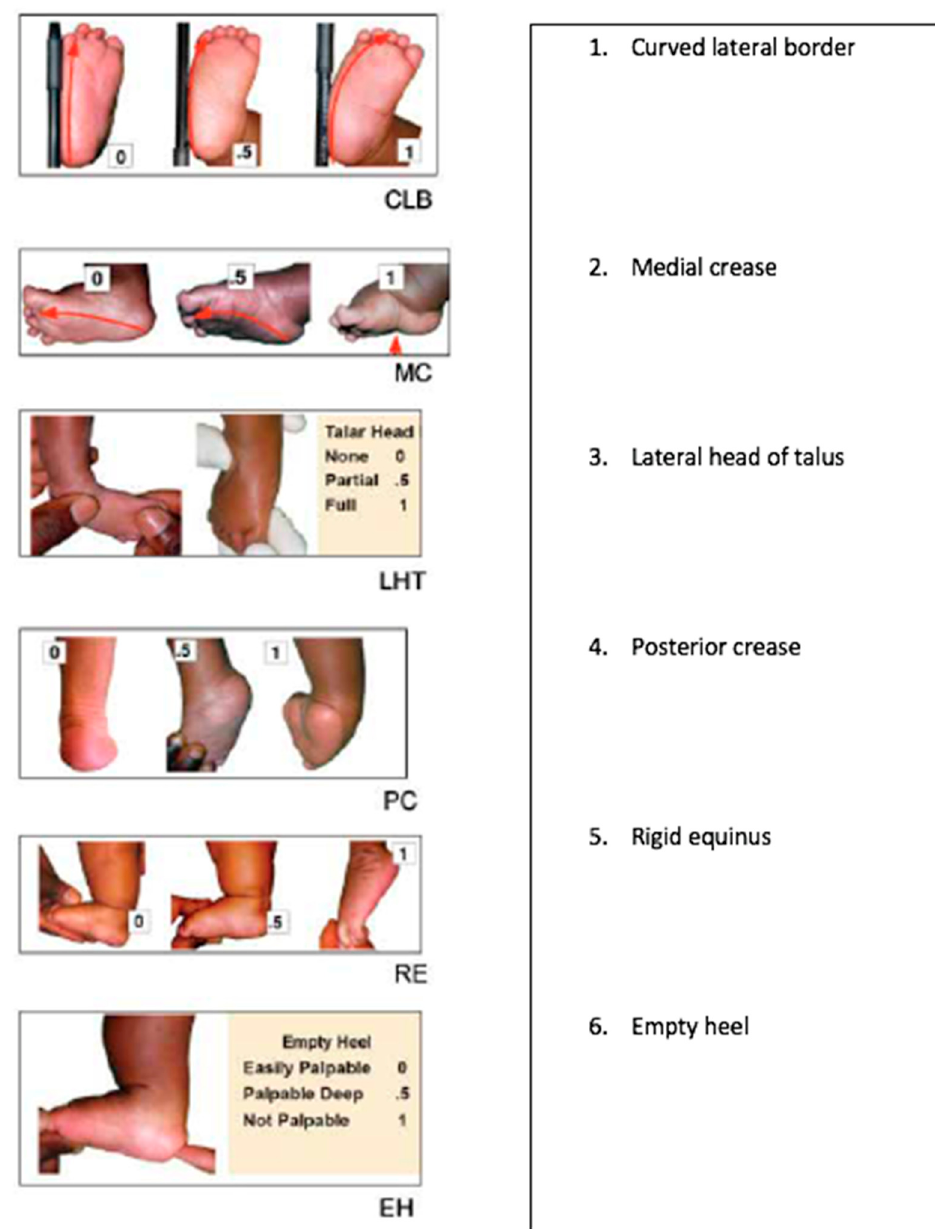
Figure 1. Initial clubfoot severity is rated using six clinical signs of foot deformity (Pirani